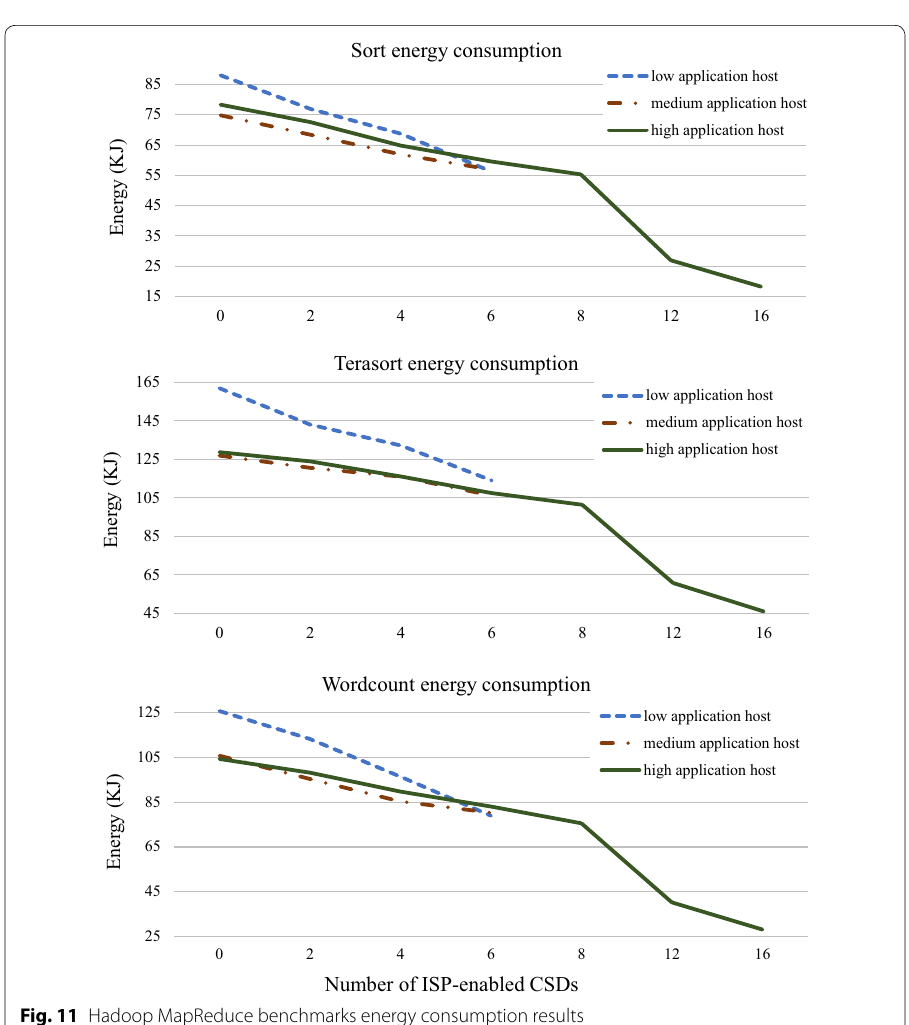
Fig. 11 Hadoop MapReduce benchmarks energy consumption